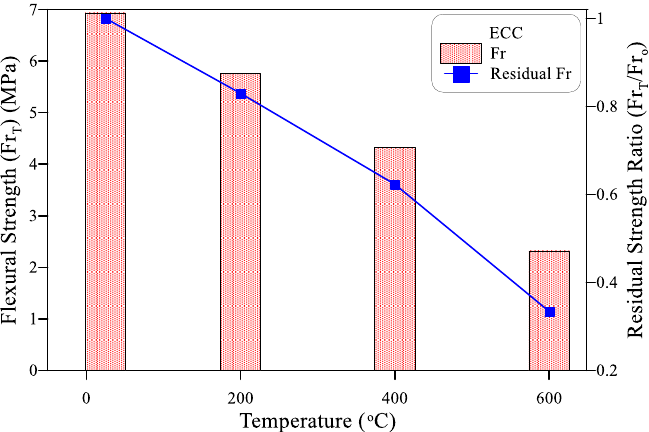
Figure 5. Residual flexural strength of ECC at different temperatures.